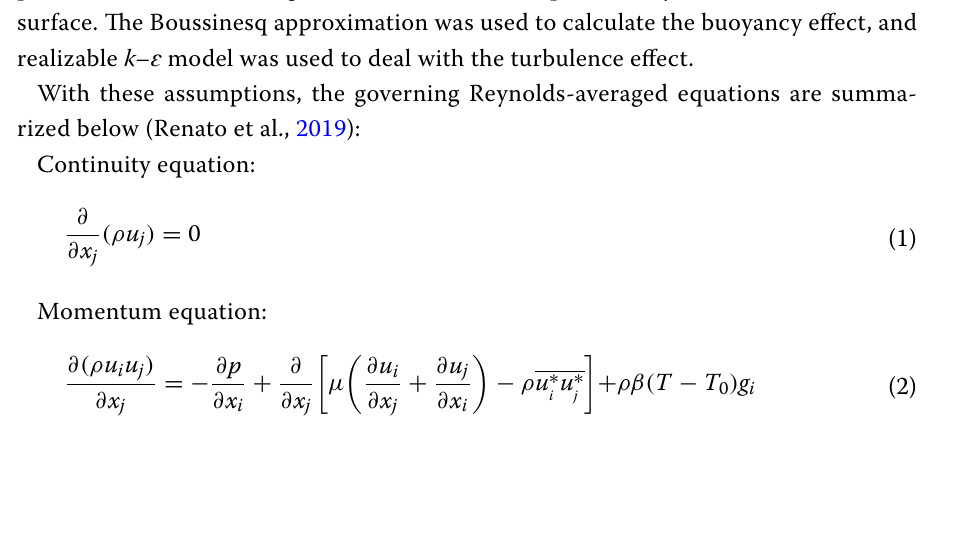
Fig. 2 Mesh independence check and method evaluation. a The contours of y convergence tests, c wearable convective cooling system, d model validation with public